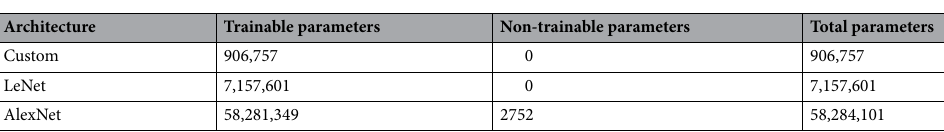
Table 1. Parameters for each architecture, first column represents the architecture, the rest represents the trainable, non-trainable and total parameters of each architecture.